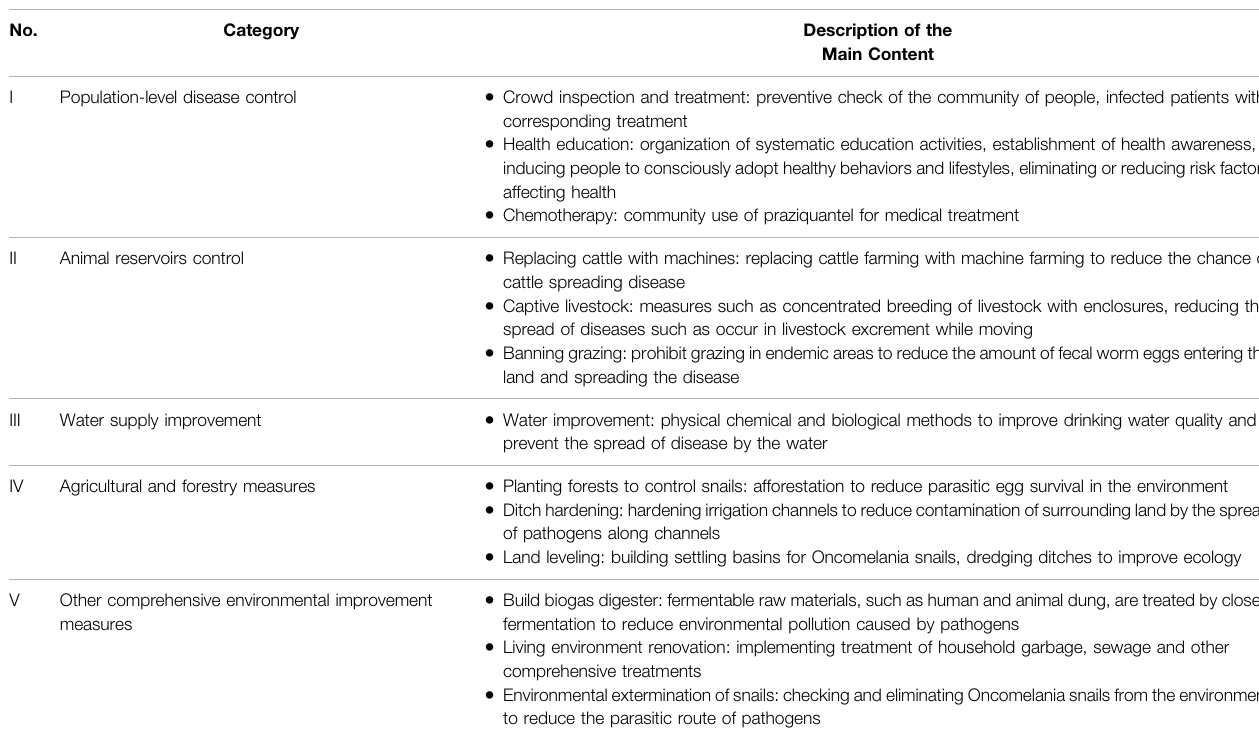
TABLE 1 | Classi fi cation of